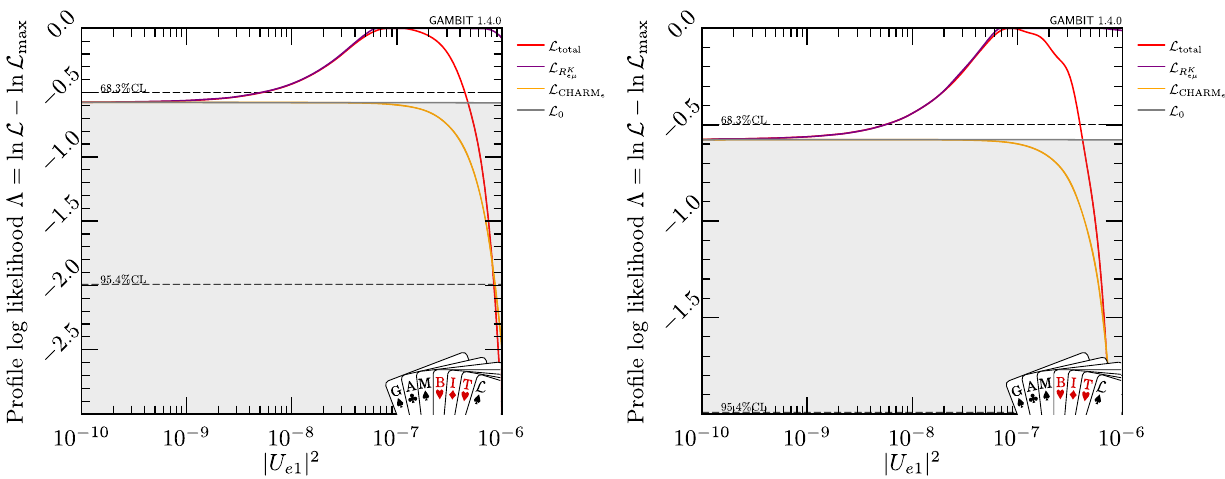
Fig. 18 One-dimensional profile likelihood for U 2 , L total , and partial likelihoods for R K , CHARM and combination of the rest of constraints, e 1 < 1 GeV, for normal (left) and inverted hierarchy L 0 , in the low mass region, M 1